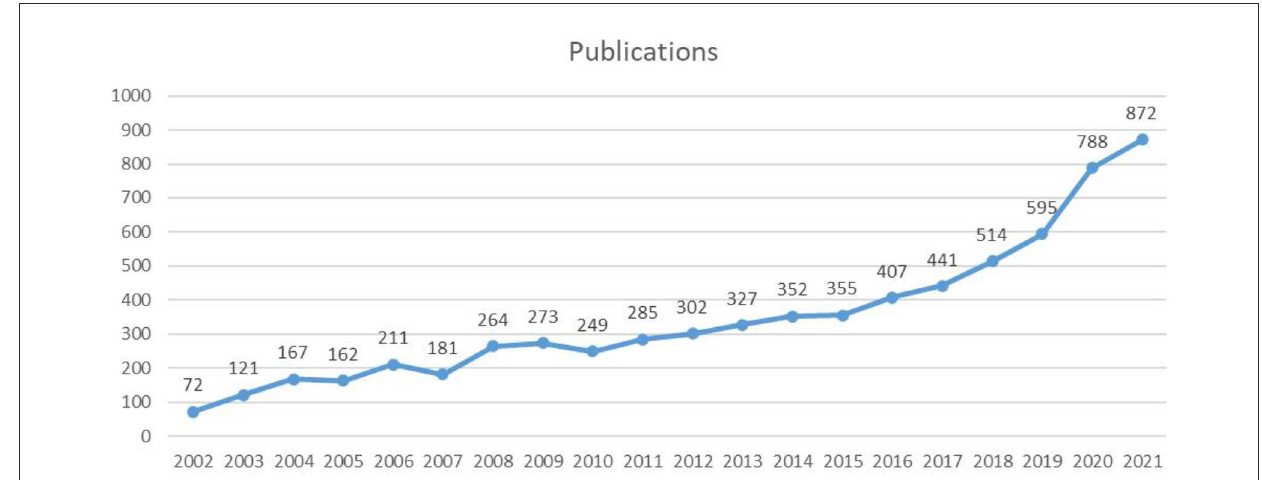
FIGURE2 The annual number of publications on LChD from 2002 to